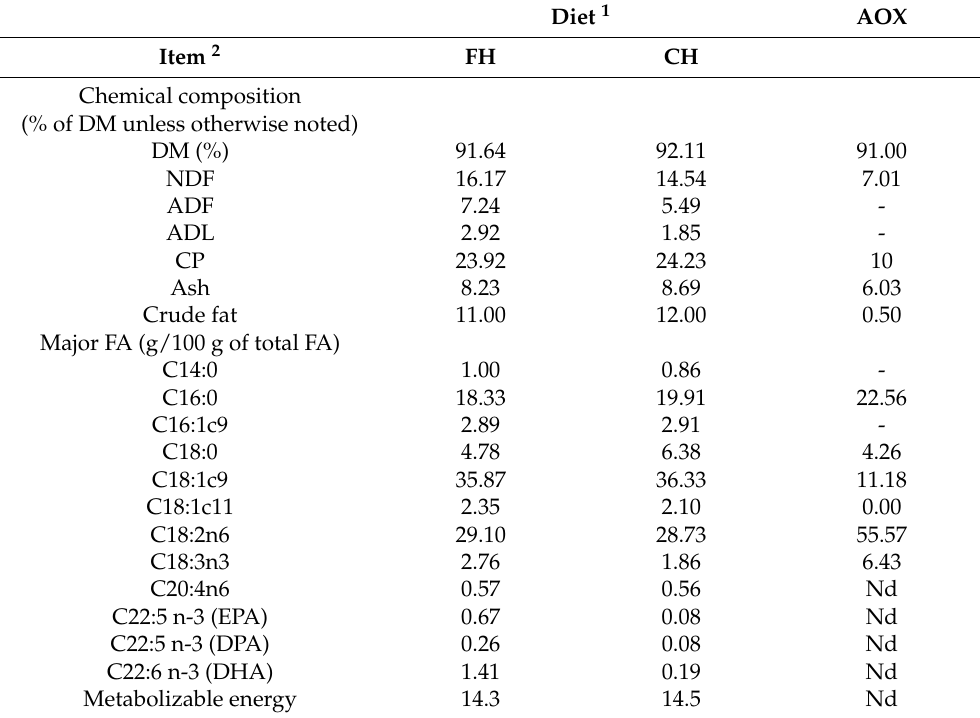
Table 2. Ingredients and chemical composition and fatty acid (FA) profile of two diets and the antioxidant supplement. Diet 1 AOX Item 2 FH CH Chemical composition (% of DM unless otherwise noted) DM